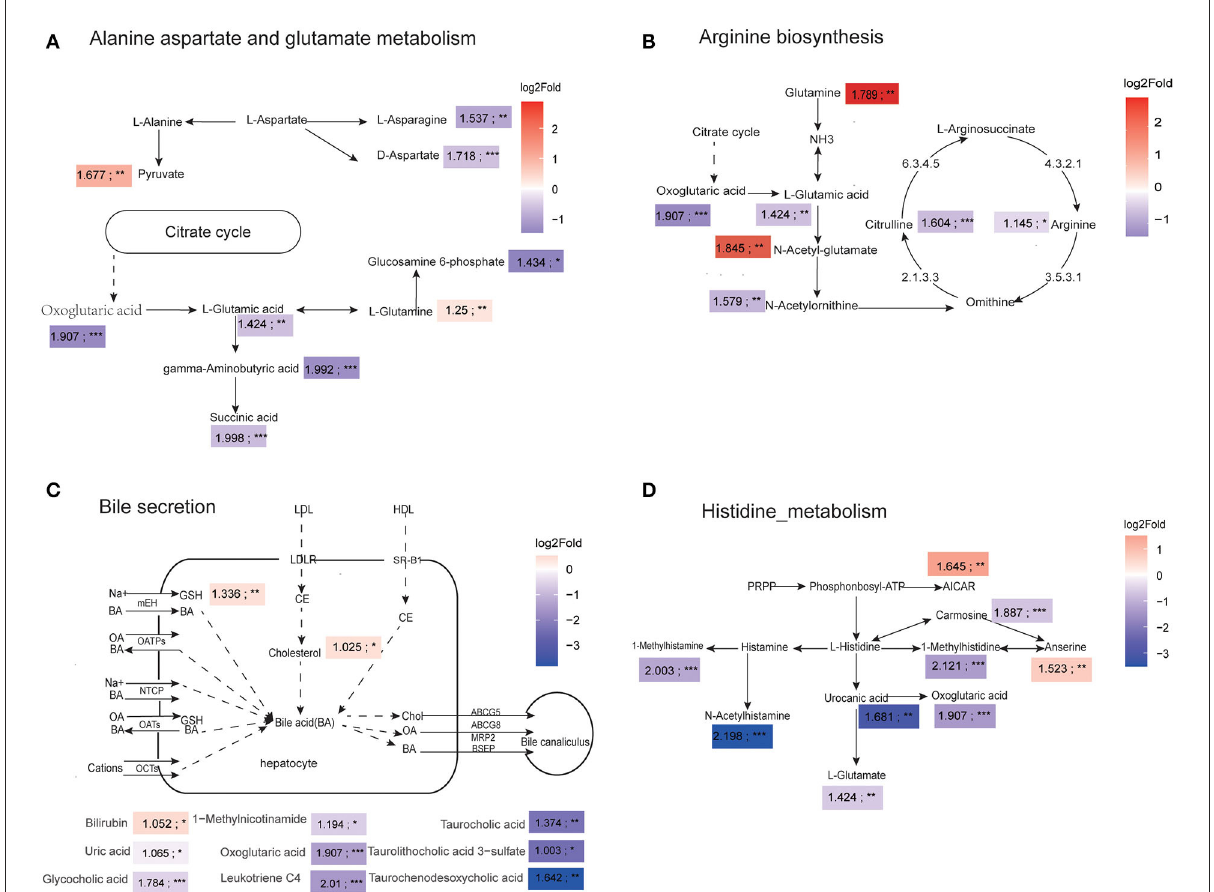
FIGURE4 Amino acid and bile metabolism pathways were compromised in adult canines. (A–D) The four major metabolic networks showed significantly changed metabolites in alanine aspartate and glutamate metabolism pathway (A) , arginine biosynthesis pathway (B) , bile secretion pathway (C) , and histidine metabolism pathway (D) . Color scale represents log2 fold change. Red represents metabolite abundances in adult dogs higher than that in young dogs and purple depicts metabolites with decreased abundance in adult dogs relative to young dogs; The value represents the VIP value of the OPLS-DA model; * P < 0.05, ** P < 0.01, *** P < 0.001 vs. young group.